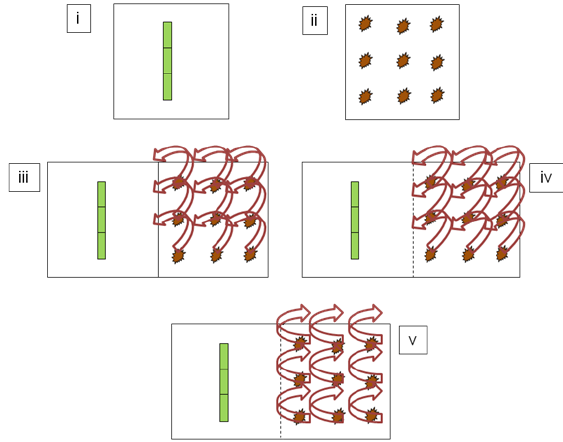
Figure 1 - Schematic diagram of the experimental treatments: (i) sugarcane monocropping, (ii) morning glory monocropping, (iii) sugarcane cropping intertwined with morning glory but in separate boxes, (iv) sugarcane cropping intertwined with morning glory but in attached boxes and (v) sugarcane intercropping with morning glory in attached boxes without intertwining with the sugarcane. The arrows indicate the growth direction of the morning glory